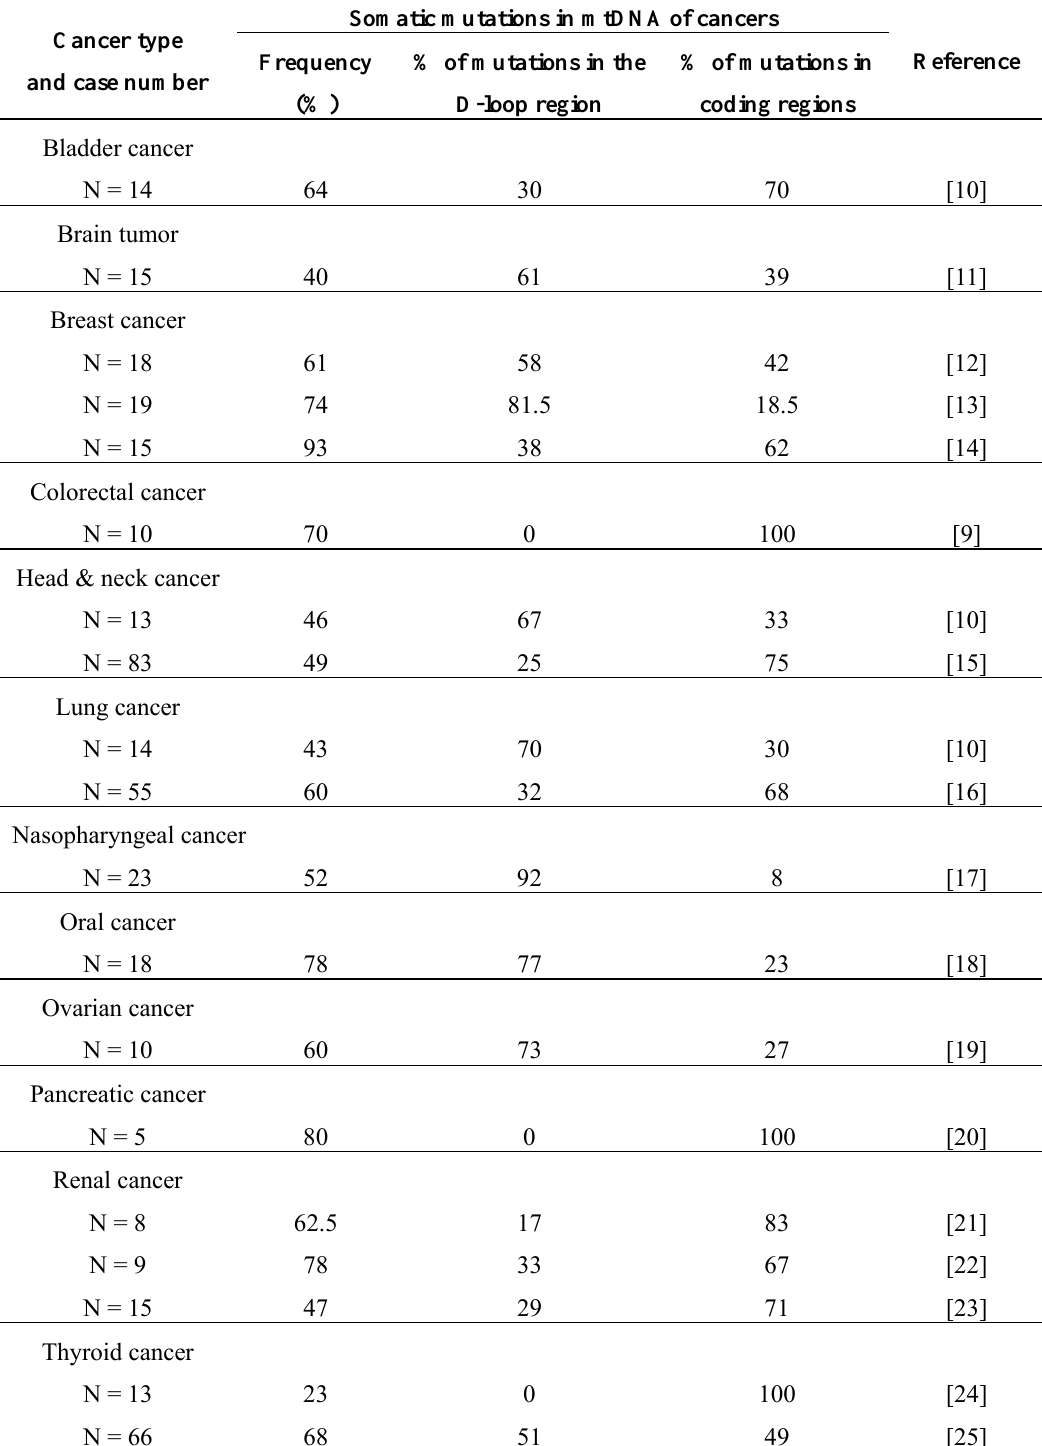
Table 1. Somatic mutations in mtDNA of human